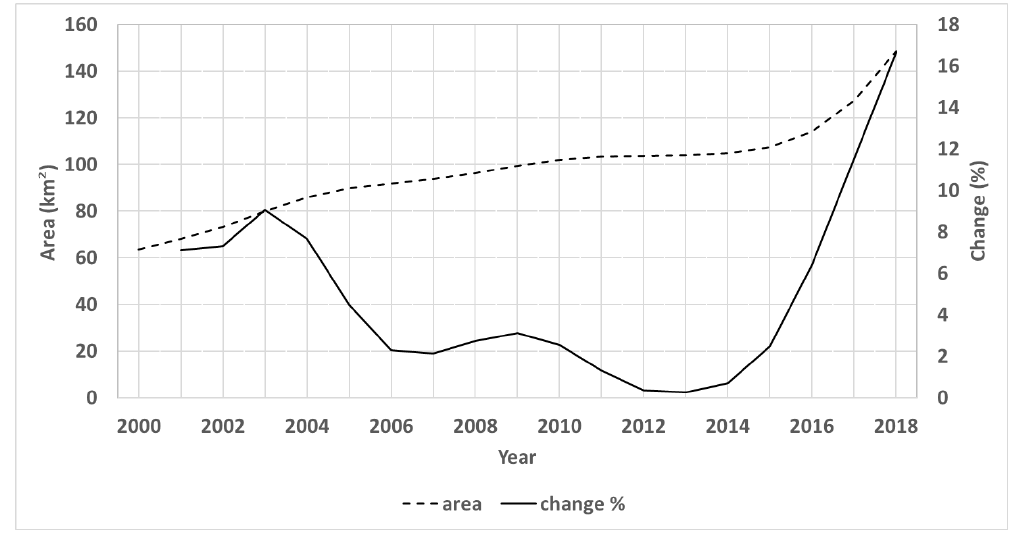
Figure 8. Settlement area and increased percentage in the study region from 2000 to